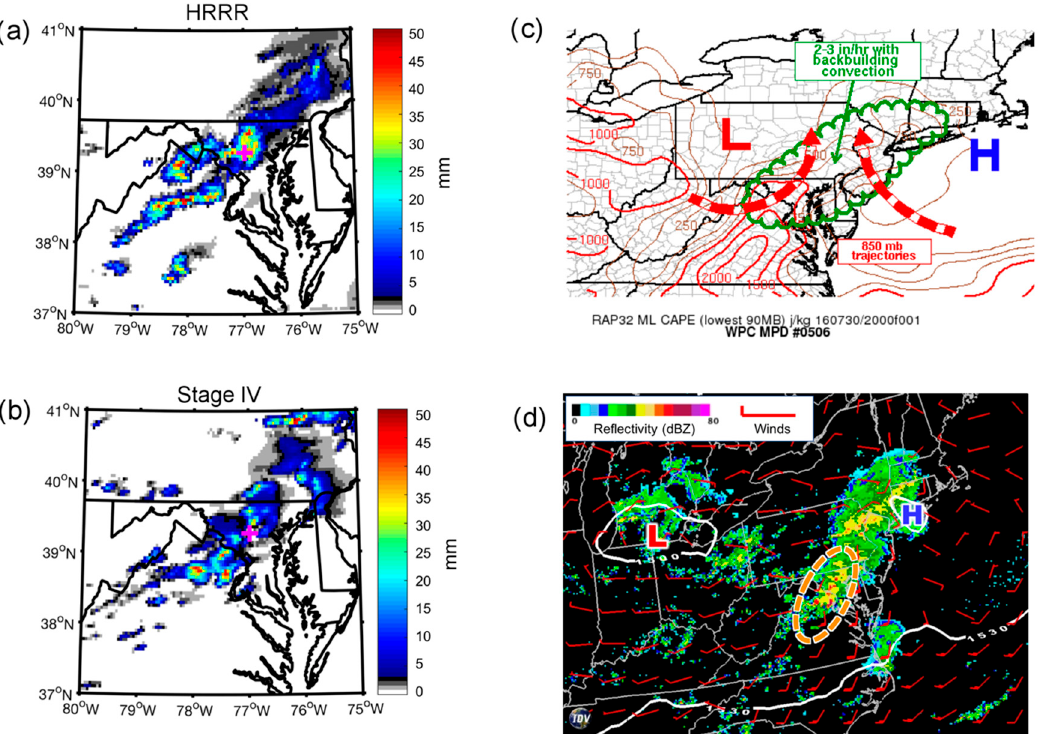
Figure 8. Summary for 30 July 2016: ( a ) Stage IV one-hour precipitation totals valid for the period ending 23 UTC 30 July ( b ) 12 UTC HRRR one-hour precipitation forecast valid for the period ending 23 UTC 30 July ( c ) WPC analysis associated with a mesoscale precipitation discussion issued at 17:00 EDT on 30 July 2016, and ( d ) 12 UTC HRRR forecast 850 mb winds (red vectors), geopotential heights (white contours), and model simulated composite reflectivity valid at 23 UTC Jul 30 (image made in IDV). In ( d ) a region of convergence over central Maryland is indicated by an orange dashed oval.